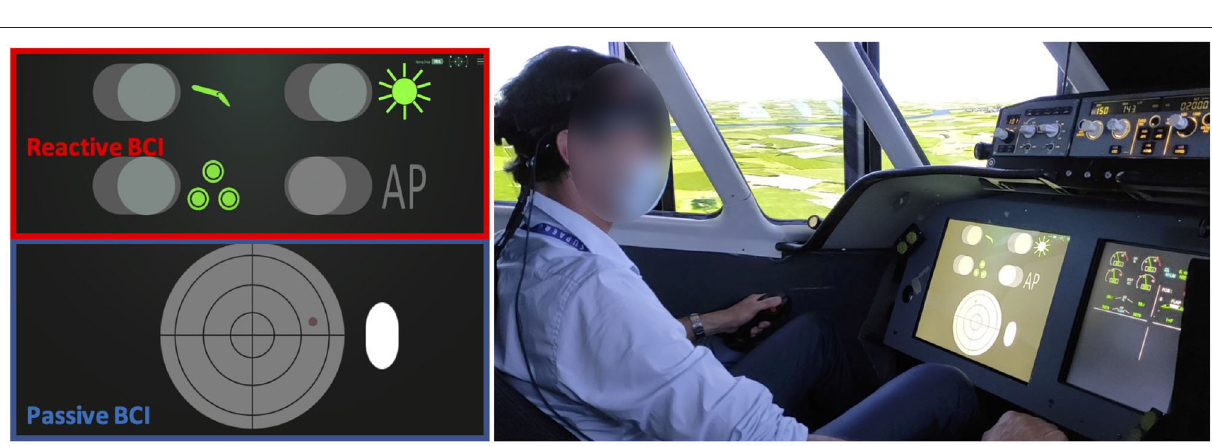
FIGURE 2 | (Left) The participants had to perform the checklists with the reactive BCI (in red, upper part of the screen) while their monitoring performance on the radar screen was assessed with the passive BCI (in blue, lower part of the screen). (Right) The dual BCI setup in the flight